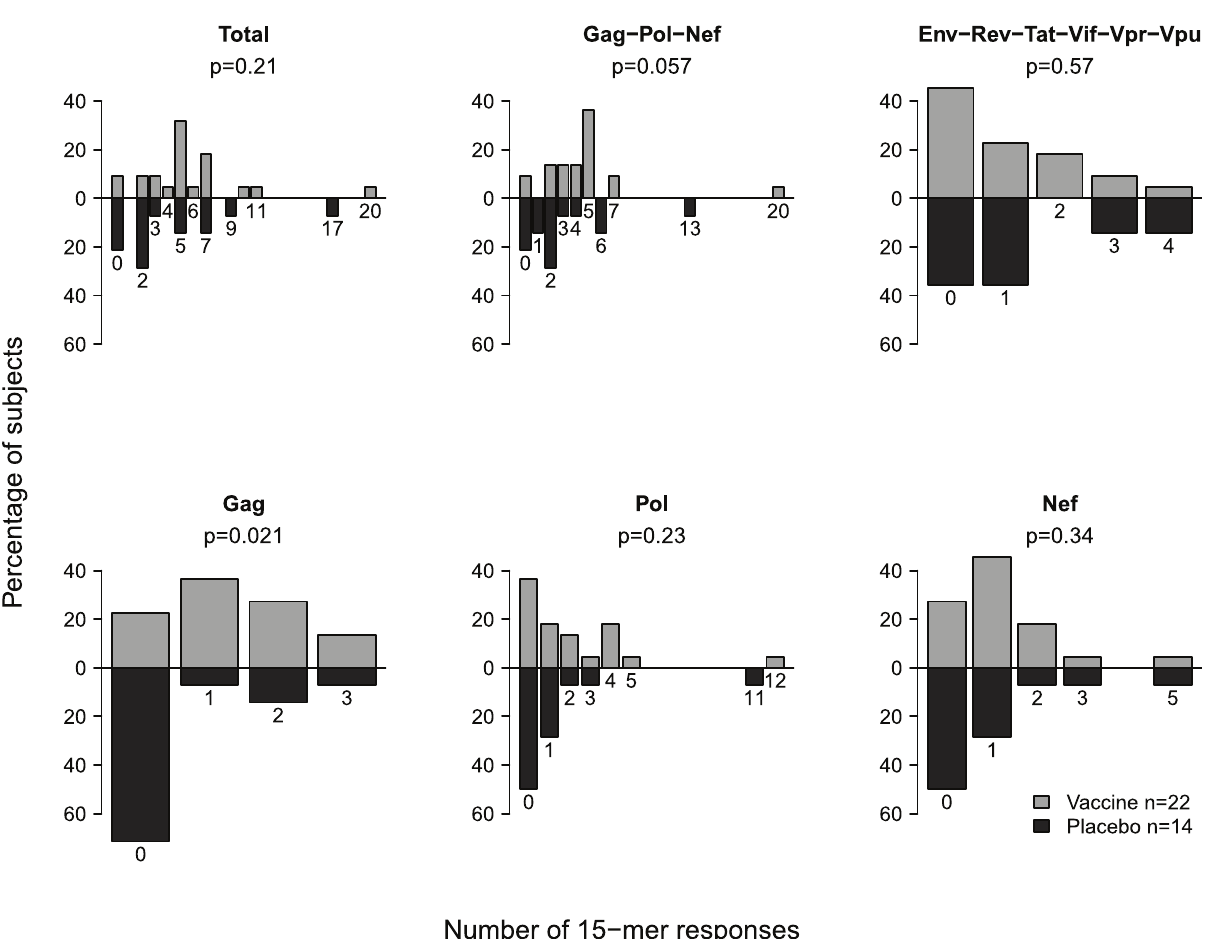
Figure 2. Post-Infection Breadth of T-Cell Response. Breath of the post-infection T-cell response as measured by IFN c ELISpot, as quantified by the number of reactive 15-mers, for the vaccine (grey) and placebo (black) groups. The distribution of breadth is shown for all proteins in aggregate; for Gag, Pol, and Nef combined; for other non-insert proteins; and for Gag, Pol, and Nef individually. The p-values refer to tests comparing breadth between vaccine and placebo